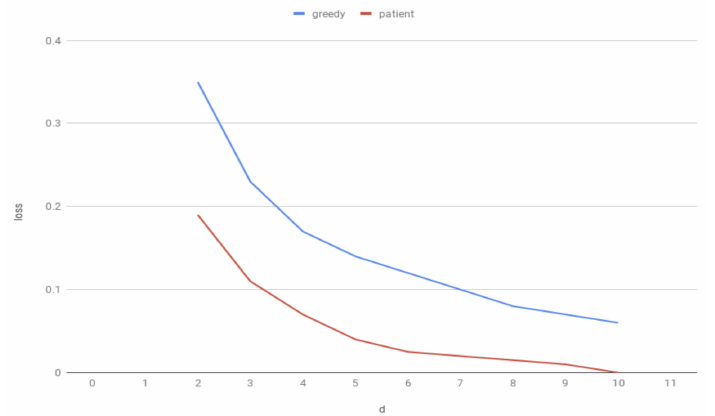
Figure 10. System losses vs. the number of expected links per node, d, if the patient and the greedy matching strategies are